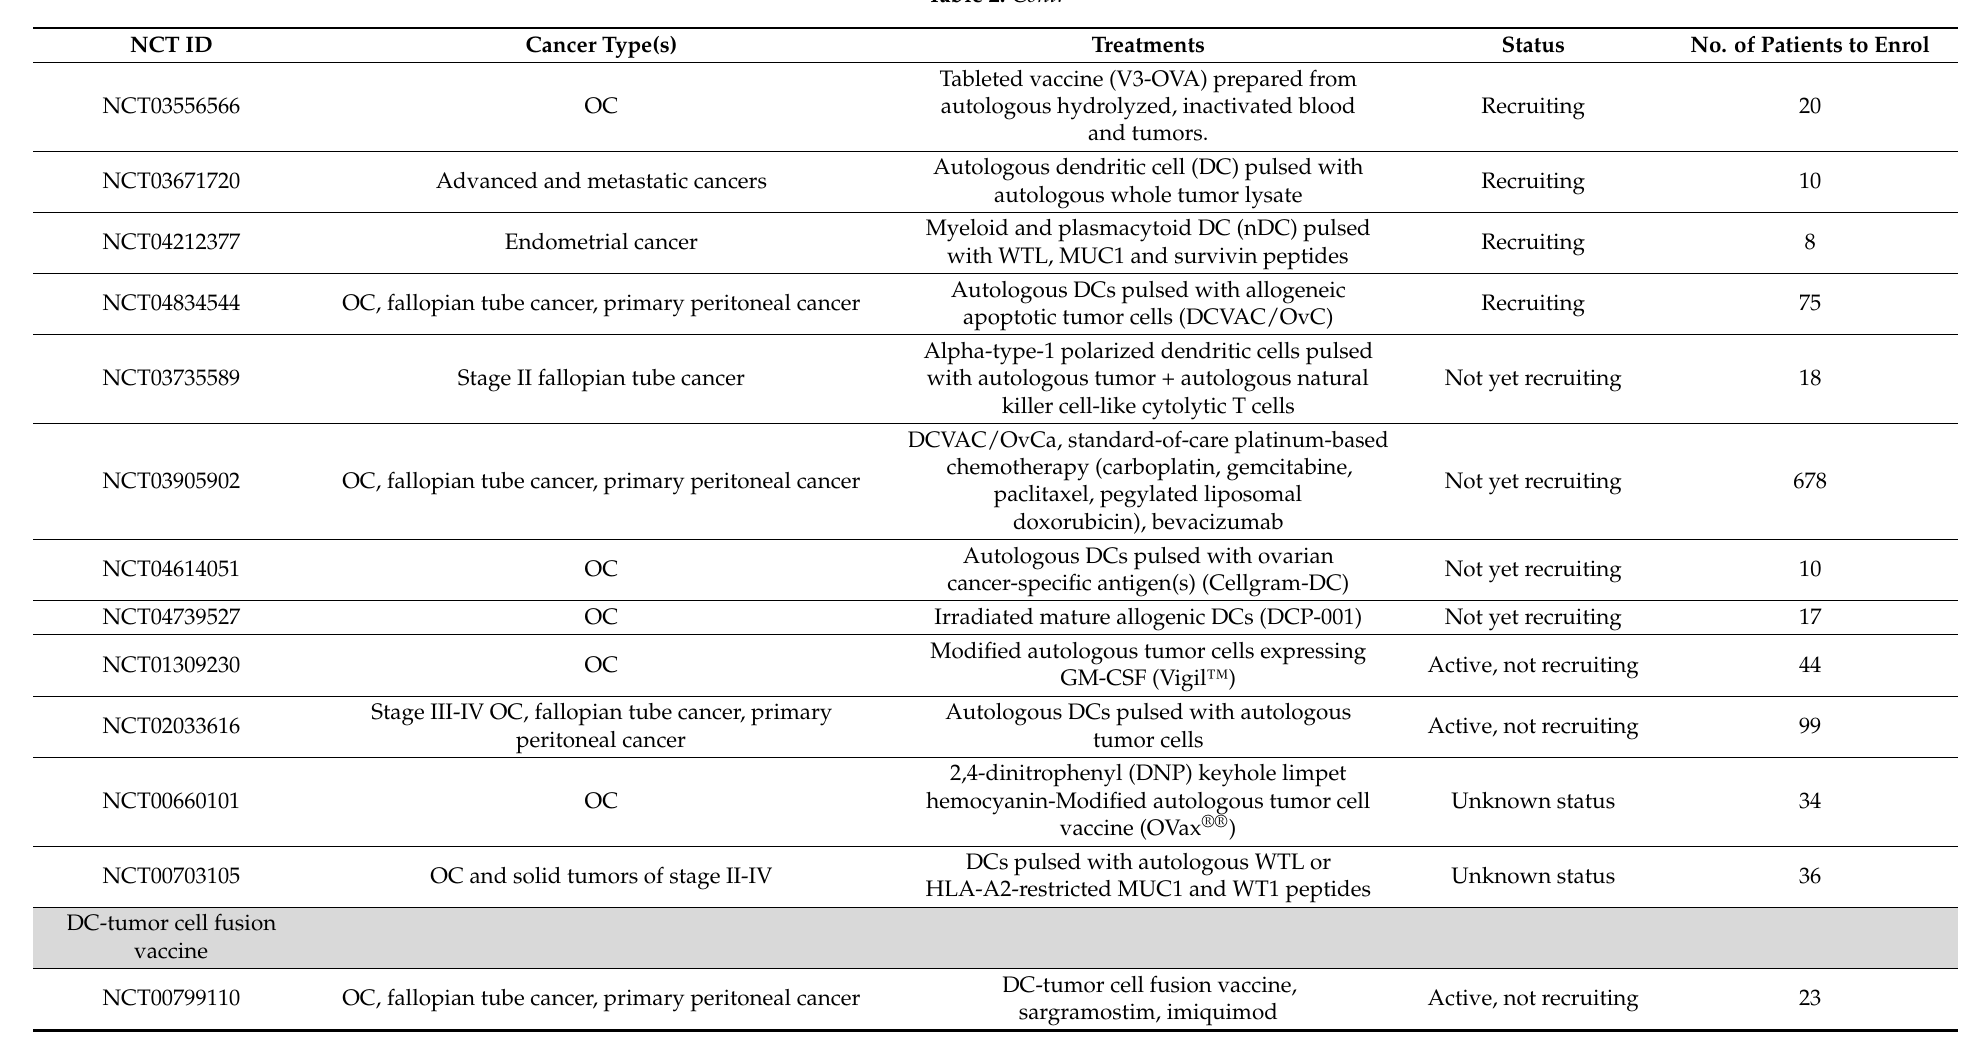
Grey: to highlight and separate the different forms of cancer vaccines listed in the